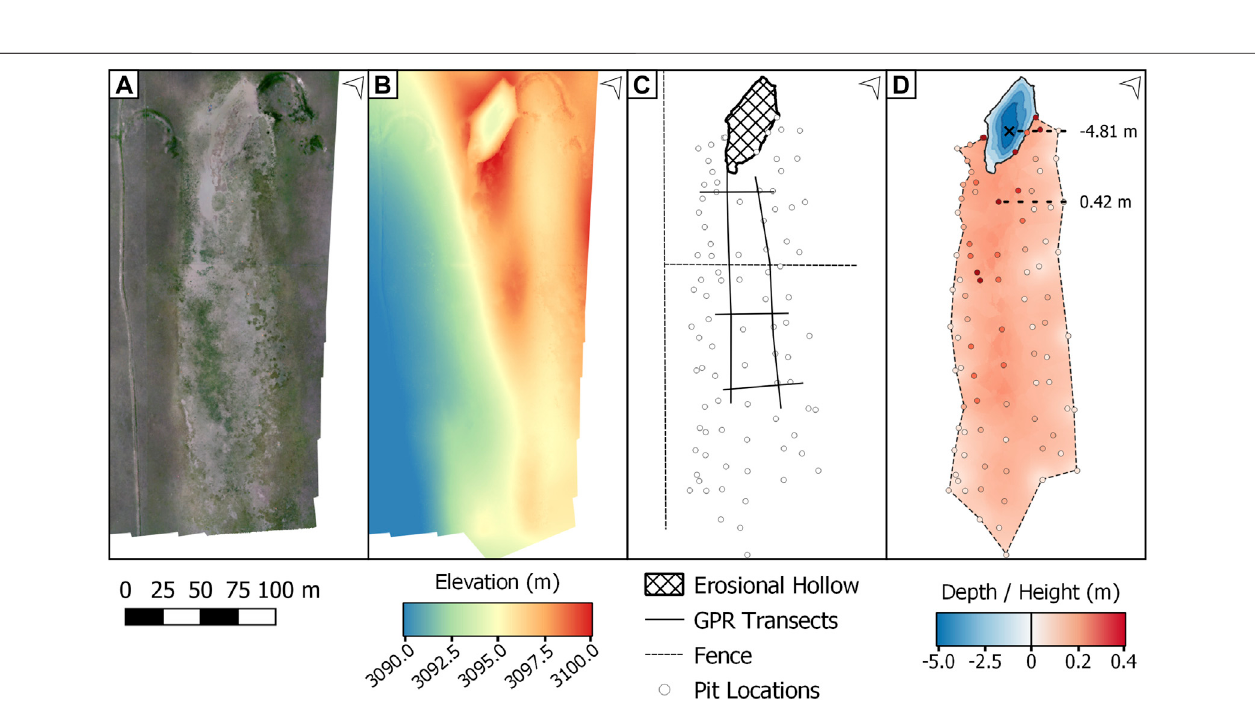
FIGURE8| BlowoutCviewed as( A ) atrue colorcomposite;( B )adigitalelevation model; and ( C ) aschematic model withground-penetratingradartransects;and ( D ) interpolated hollow depth and apron soil thickness with pit sample locations. Coordinates of the top-left corner of the bounding box: 35.95123N, 100.29763E; bottom-right corner: 35.94985N,